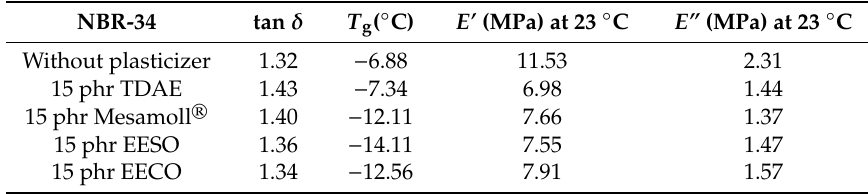
Table 2. Dynamic mechanical analysis (DMA) analysis of NBR-34 vulcanizates with various plasticizers.